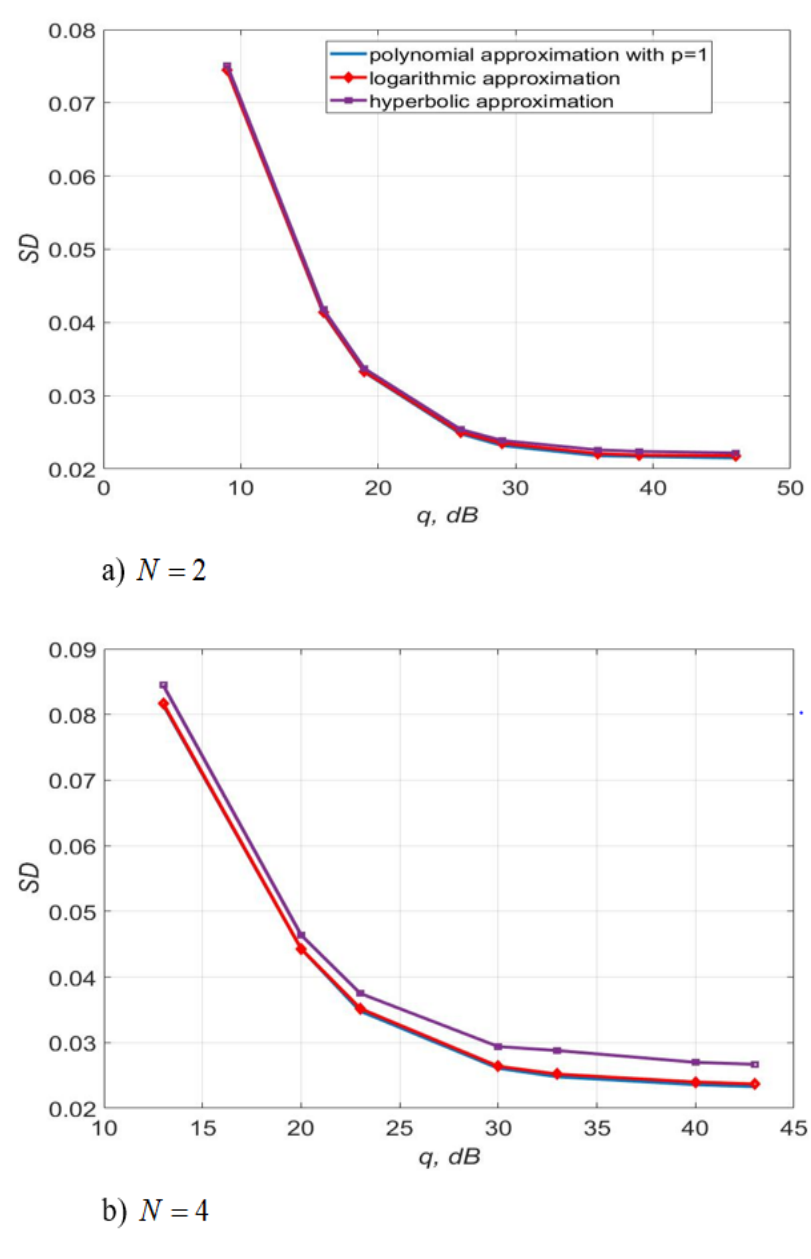
Figure 18. The SD of the channel gains estimation versus SNR per bit for different approximating structures for MIMO systems.